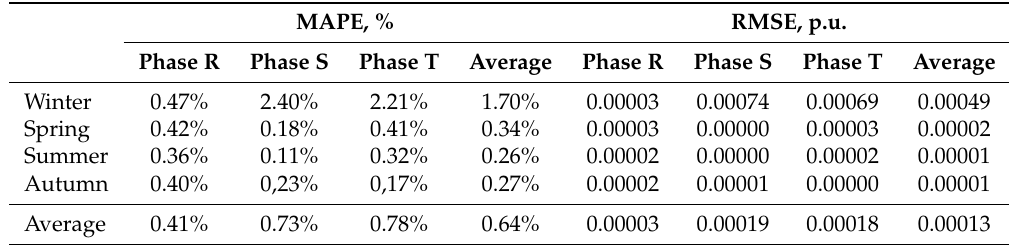
Table 4. Model validation. Mean Absolute Percentage Error (MAPE) and the Root-Mean-Square Error (RMSE) values obtained for the electrically furthest node.